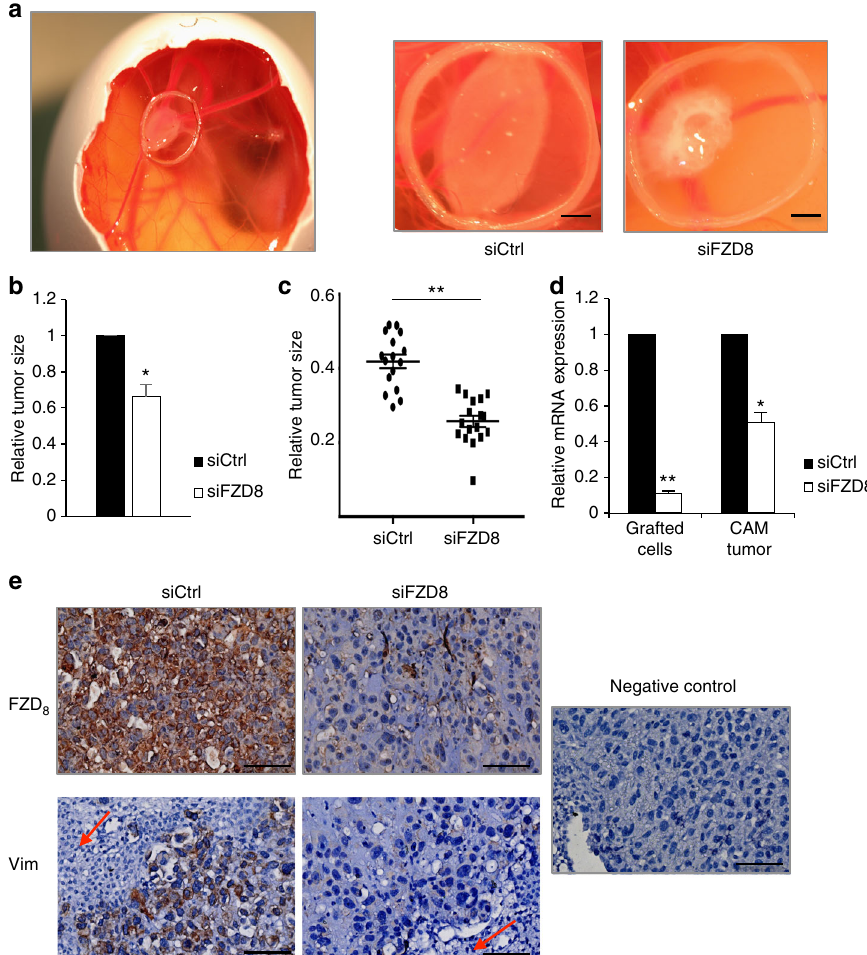
Fig. 4 FZD8 is required for tumor growth in vivo. a Representative pictures of PC-3-derived tumors implanted on the CAM for 3 days. Left, overview image of the egg; right, representative tumors from PC-3 cells transfected with control (siCtrl) and FZD8 siRNAs. Implantation area is con fi ned by a plastic ring; scale bars ~5 mm. b Average tumor size, as determined by ImageJ, relative to control tumors. Error bars indicate SD from three independent experiments, each with 12 – 15 eggs per condition (* p < 0.05 by Student's t -test). c Boxplot of tumor size in a representative experiment with 12 – 15 eggs per condition (** p < 0.001 by Student's t- test). d Relative FZD8 mRNA levels were determined by q-RT-PCR at day 0, when cells were implanted on the CAM and at the endpoint, when CAM tumors were excised from the egg. Error bars indicate SD of three independent experiments (* p < 0.05, ** p < 0.001 by Student's t- test). e Immunohistochemical staining of CAM tumors. Representative images of sections immunostained for FZD 8 and vimentin in control (siCtrl) and FZD8-silenced (siFZD8) CAM tumors; arrows show chick embryo cells, which can be distinguished from PC-3 cells by the absence of vimentin